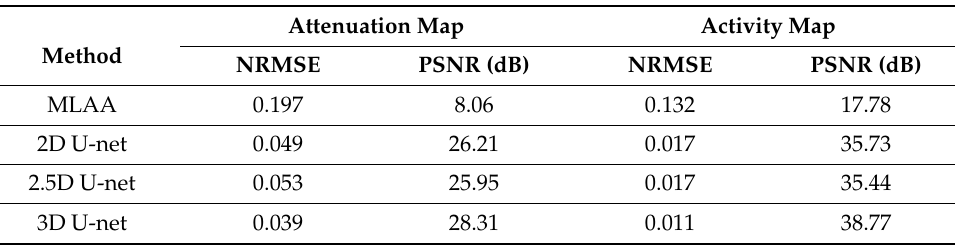
Table 3. Peak signal-to-noise ratio (PSNR) and normalized root mean square error (NRMSE) relative to the ground truth ( µ -CT and λ